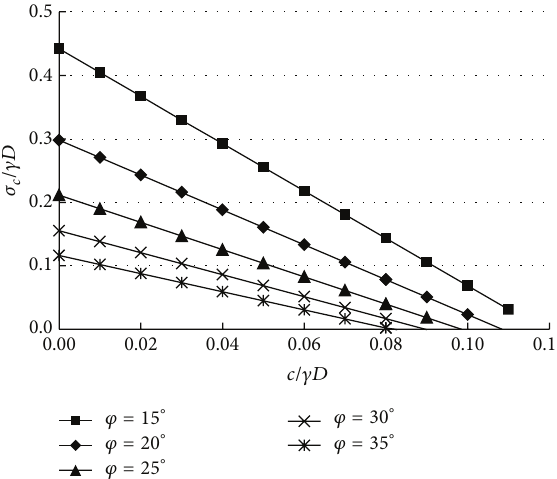
Figure 5: Design chart of critical